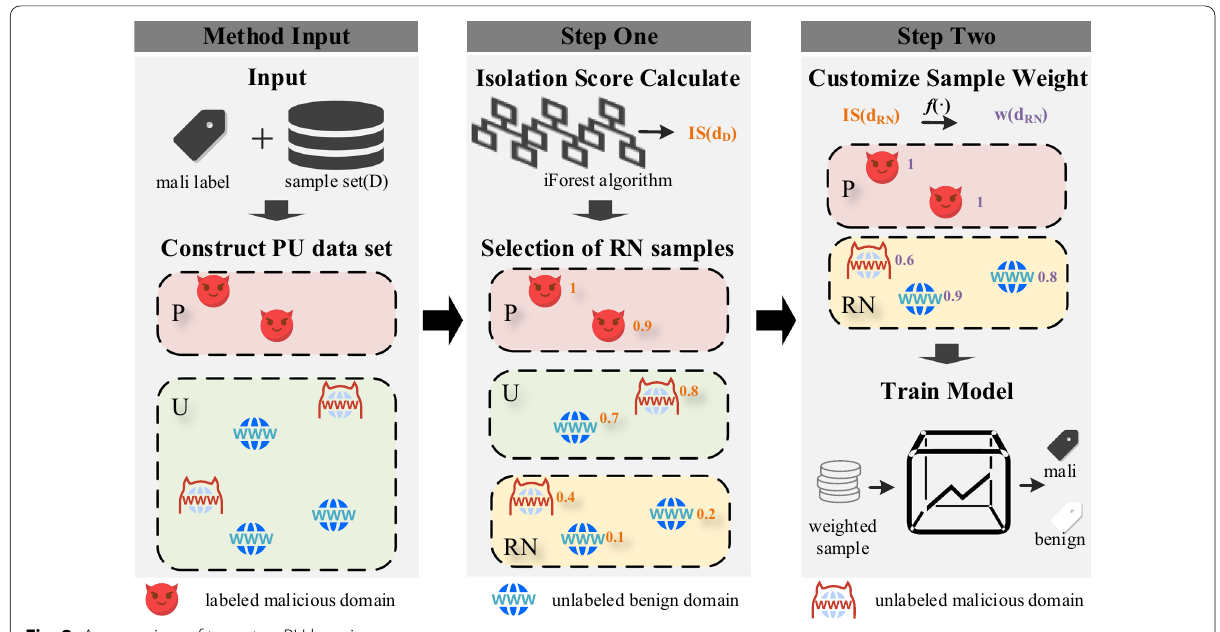
Fig. 2 An overview of two-step PU learning